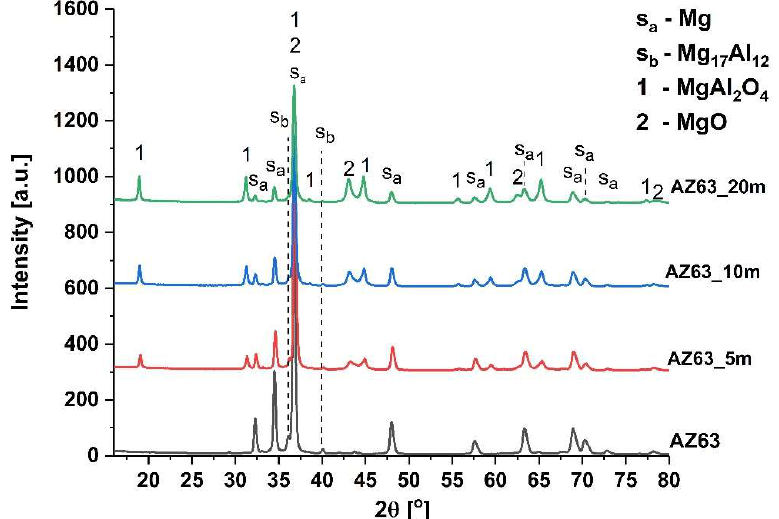
Figure 9. XRD patterns of AZ63 magnesium alloy and coated samples.